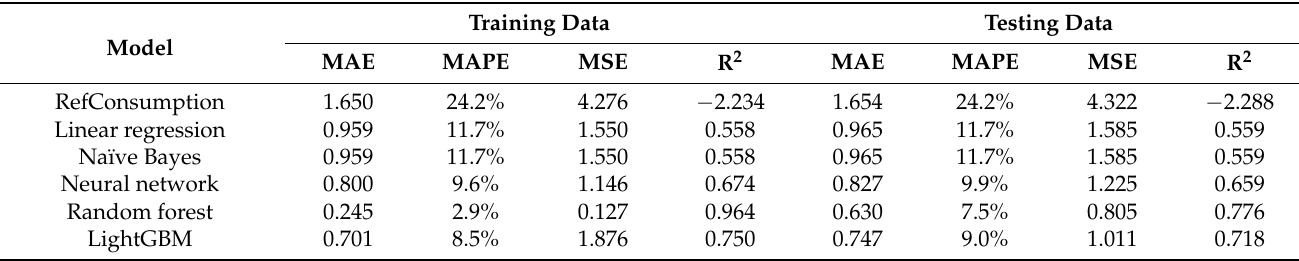
Table 7. Result of each regression